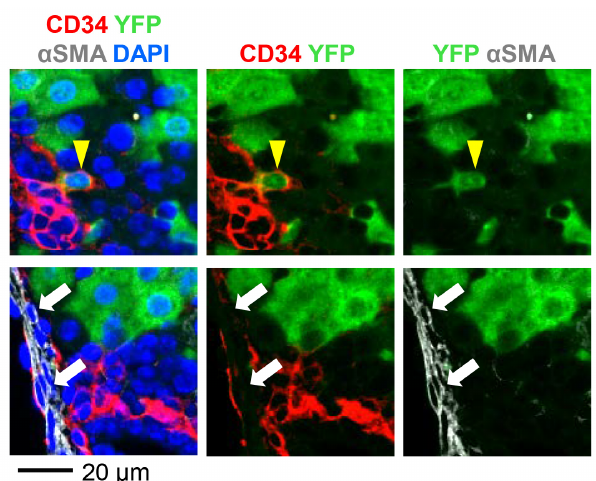
Figure 4. Rosa YFP/+ reporter mice were injected with AAV8-CMV-Cre at P2 and livers were analyzed at P10. P10. Yellow arrowhead: YFP + CD34 + α SMA- cell (upper panel). White arrows: YFP-CD34- α SMA + Yellow arrowhead: YFP+CD34+ α SMA- cell (upper panel). White arrows: YFP-CD34- α SMA+ cells (lower cells (lower panel).